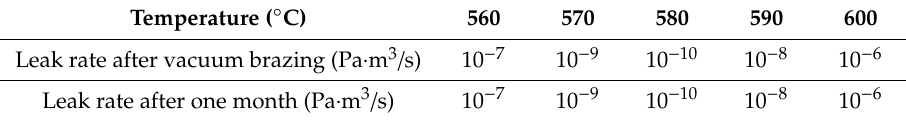
Table 3. Gas tightness of joints brazed by Al-7.5Si-23.0Cu-2.0Ni-1.0Ti at di ff erent